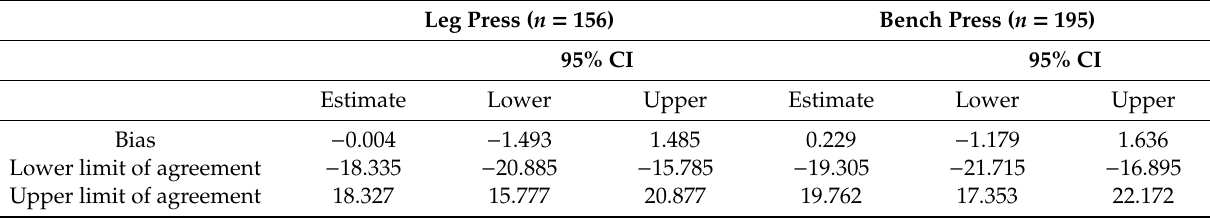
Table 4. Bland-Altman di ff erences between